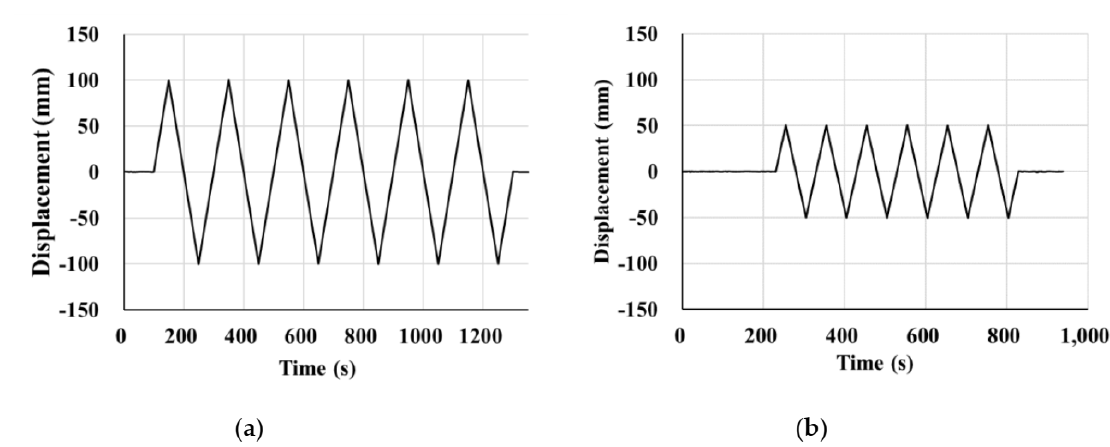
Figure 6. Lateral (shear) loading history: ( a ) NRB and LRB; ( b ) EQS.